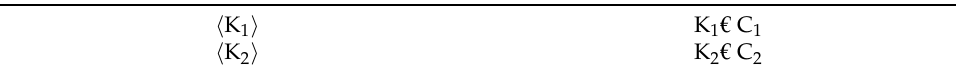
Table 4. Example, datapoint 1 (If 1 belongs to K 1 it means it is in | 0 (cid:105) state).